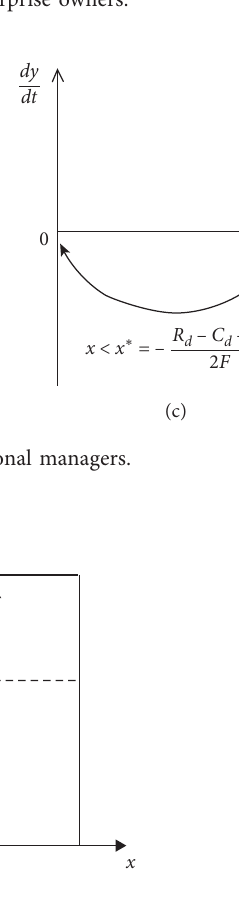
Figure 1: Dynamic evolution path of the enterprise